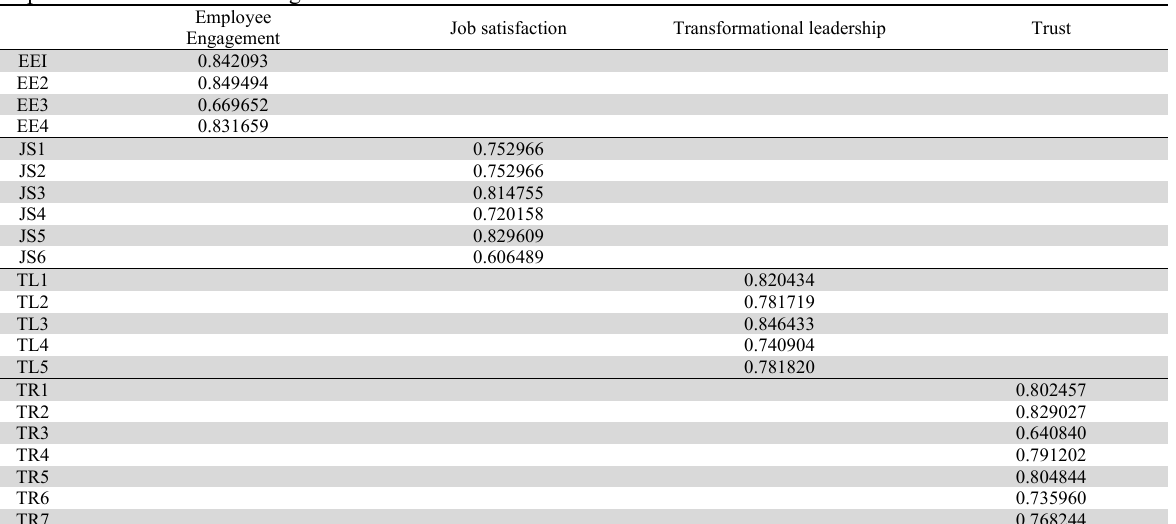
Job satisfaction Transformational